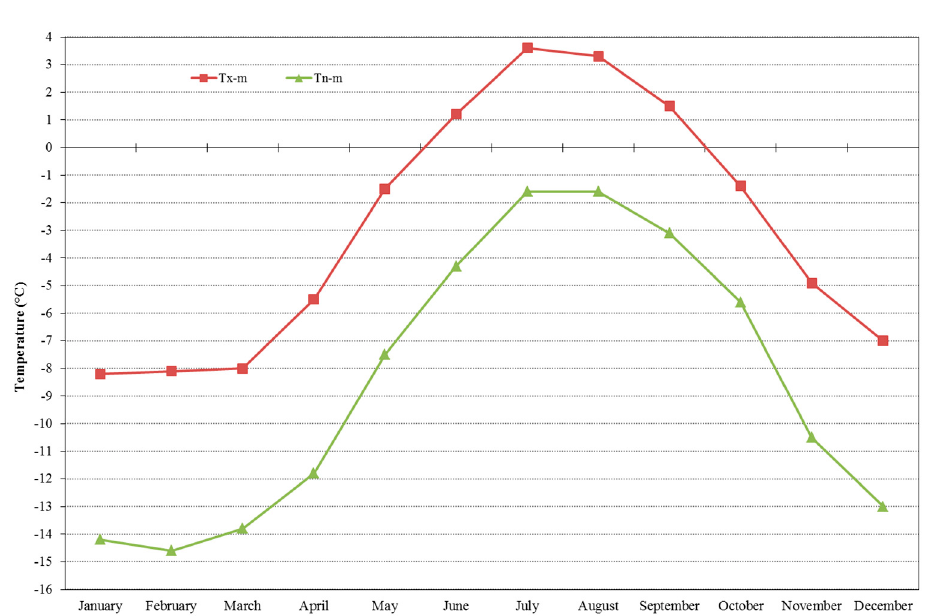
Figure 3. Mean values of the maximum (Tx-m) and minimum (Tn-m) temperatures for the 1961–1990 period [17].